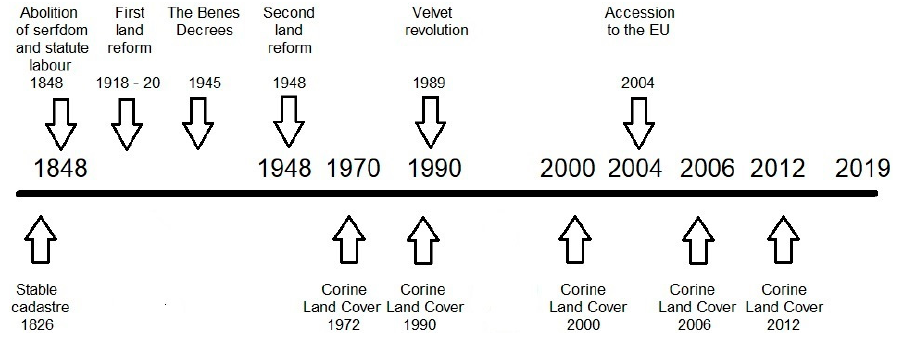
Figure 2. Illustration of selected milestones and their historical